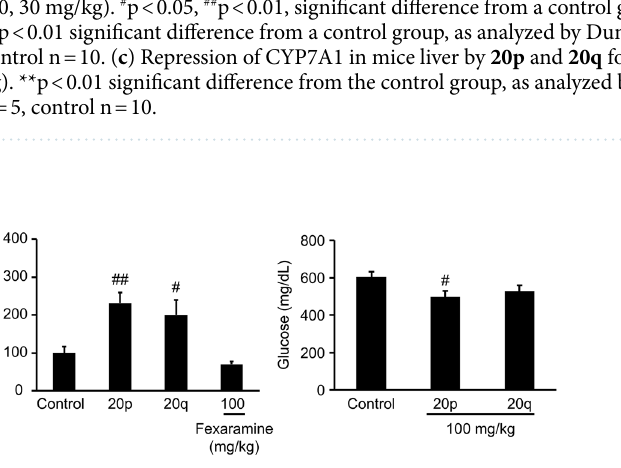
Figure 8. ( a ) GLP-1 secretion study of 20p and 20q in C57 mice. ( b ) Blood glucose levels of 20p and 20q on OGTT in C57 mice. # p < 0.05, ## p < 0.01, significant difference from the control group, as analyzed by Student’s